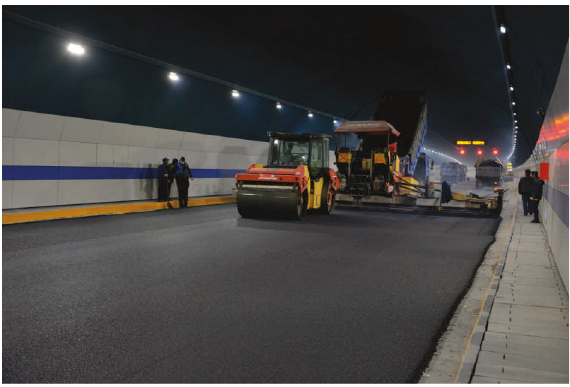
Figure 7: Paving new asphalt